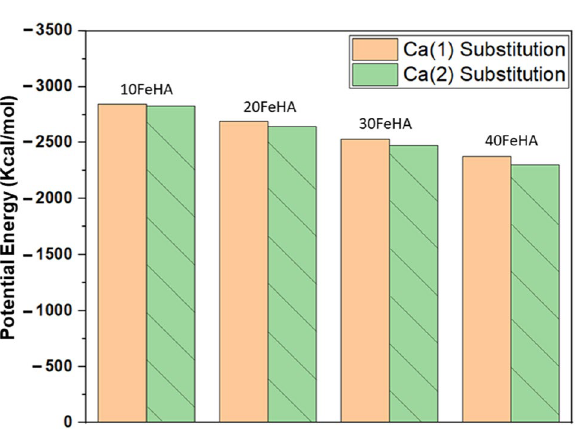
Figure 2. Minimum potential energy of doped HA structures, as determined using Materials Studio, based on the calcium substitution site. (Sample designation: xFeHA means x mol% Fe 2+ -doped